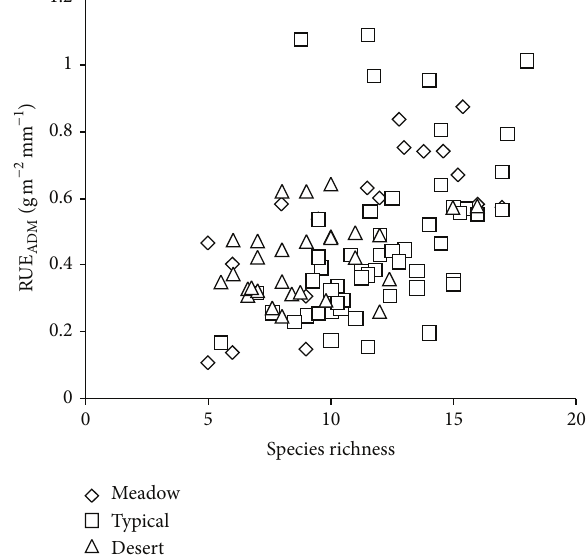
Figure 8: Relationship of RUE ADM (g m −2 mm −1 ) with species richness in meadow steppe, typical steppe, and desert steppe across thegrasslandofInnerMongolia.RUE ADM =rainuseefficiencybased on above ground dry